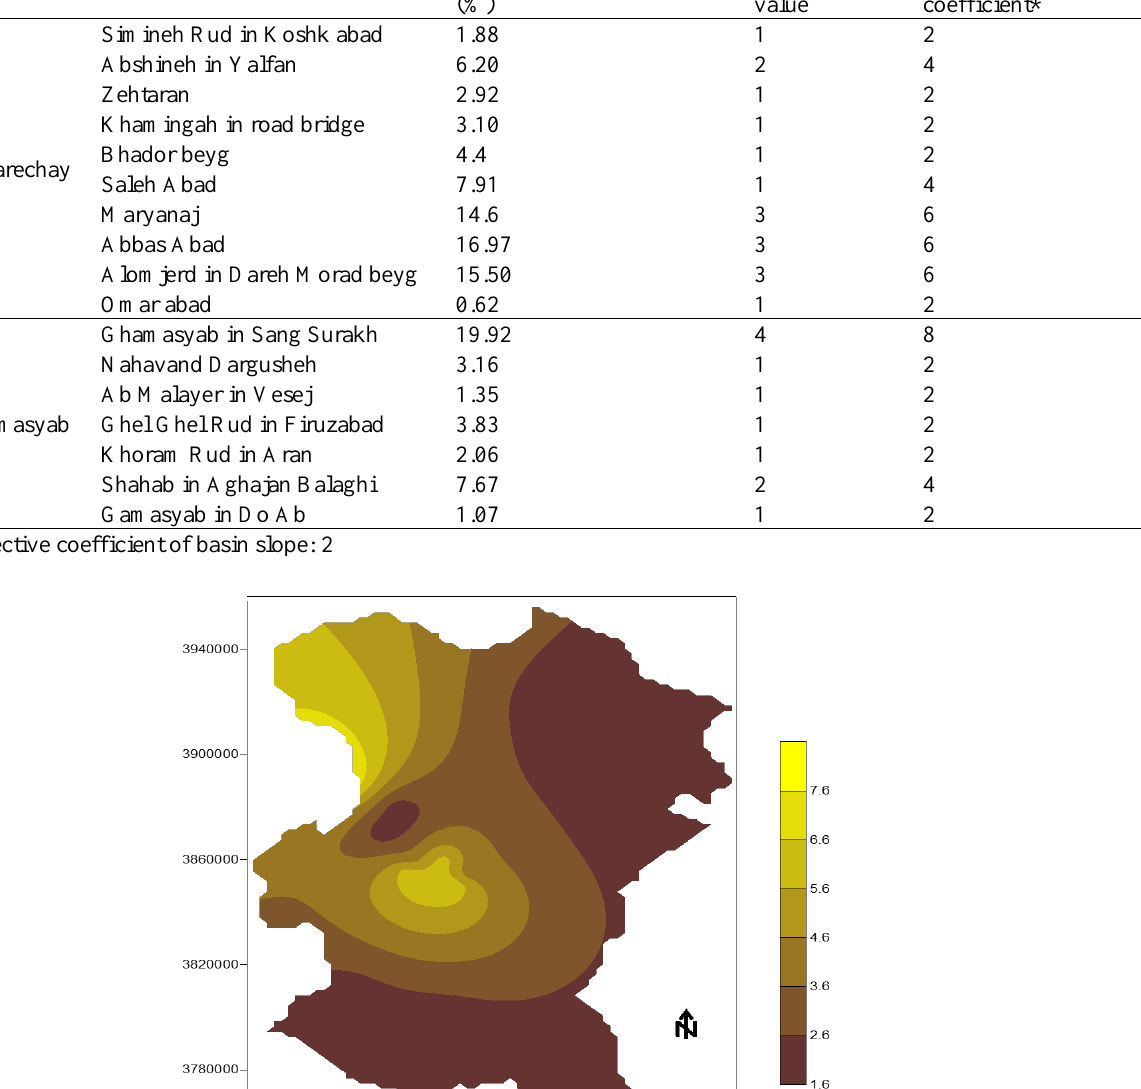
Quantitative Applying affecting value coefficient*